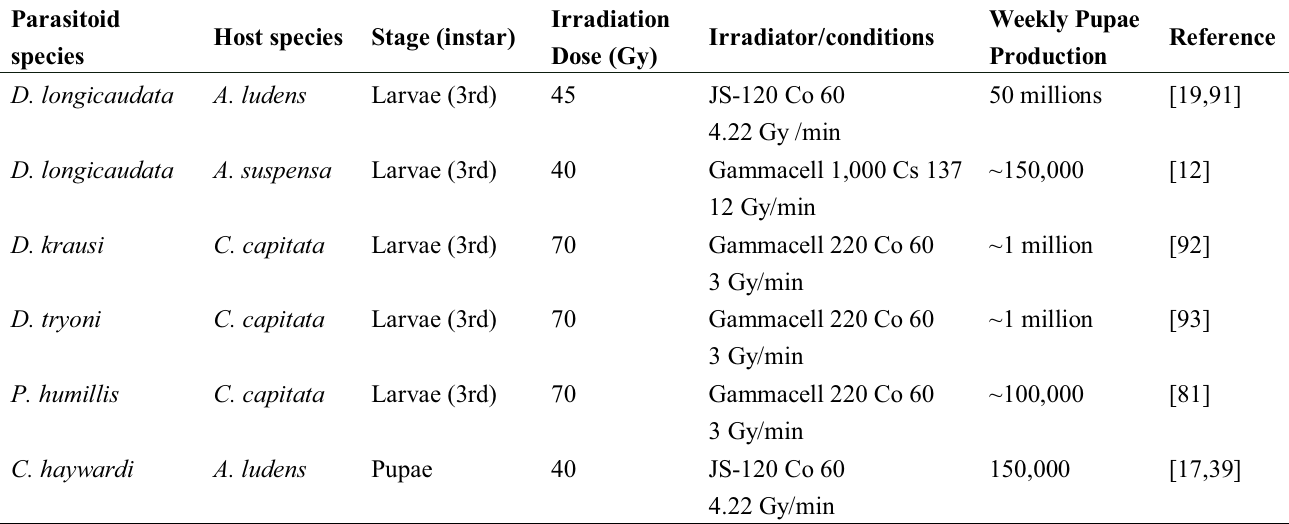
Table 3. Gamma ray doses used for irradiation of hosts in the large-scale mass rearing of fruit fly